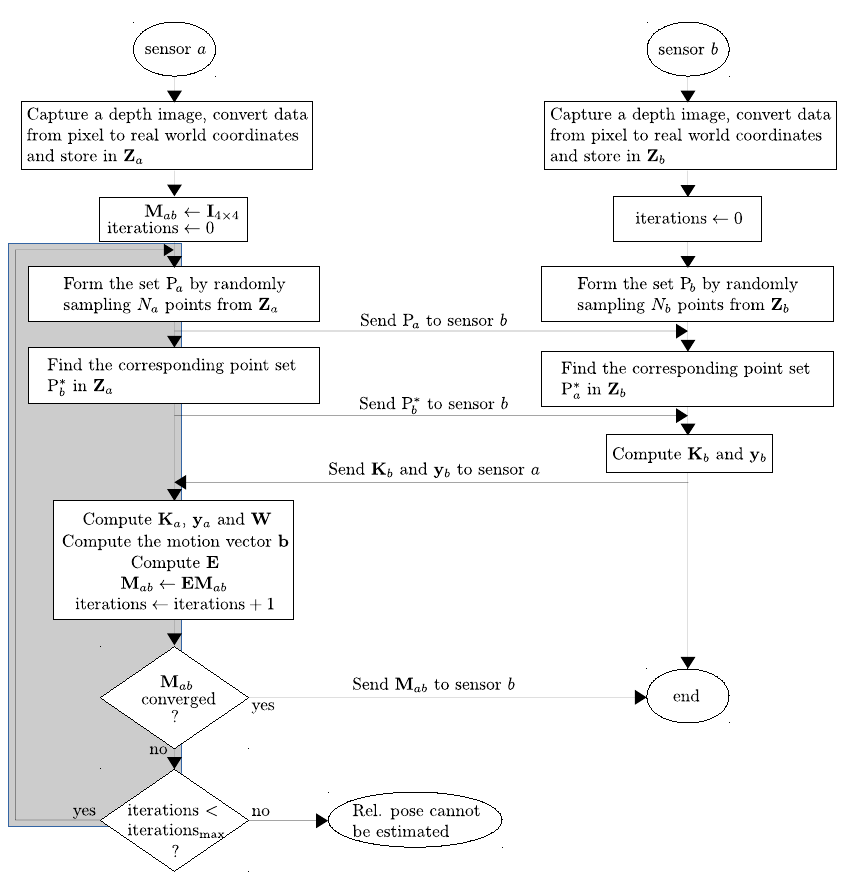
Figure 4. Operation of the cooperative relative pose estimation algorithm. The algorithm is distributed over two sensors, and operates iteratively (denoted in gray) until it converges or maximum number of iterations is reached. We have used the convergence criterion presented in [55], and iterations max is set as 50 (see Section